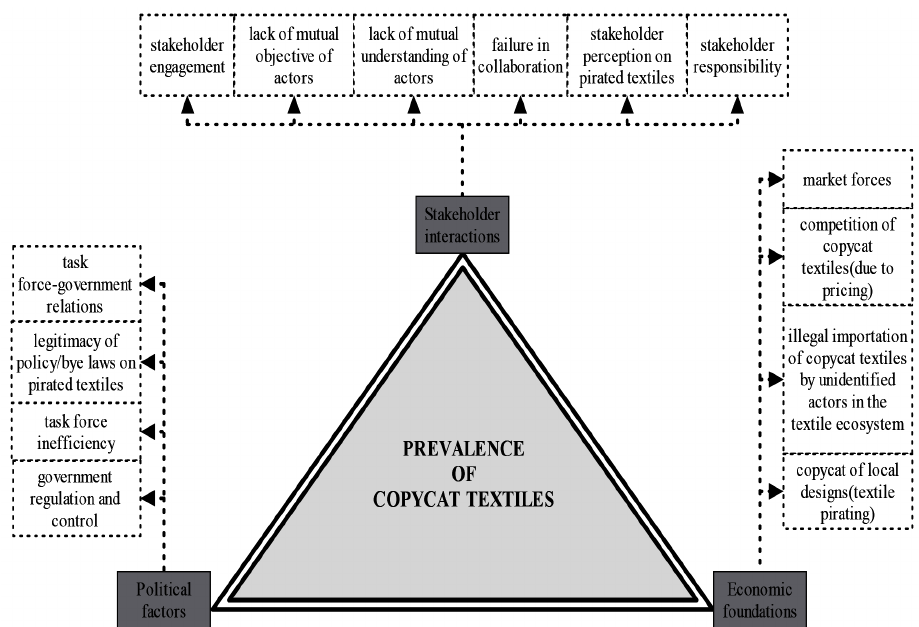
Figure 3. Triangle model for prevalence of copycat textiles in Africa (source: prepared by